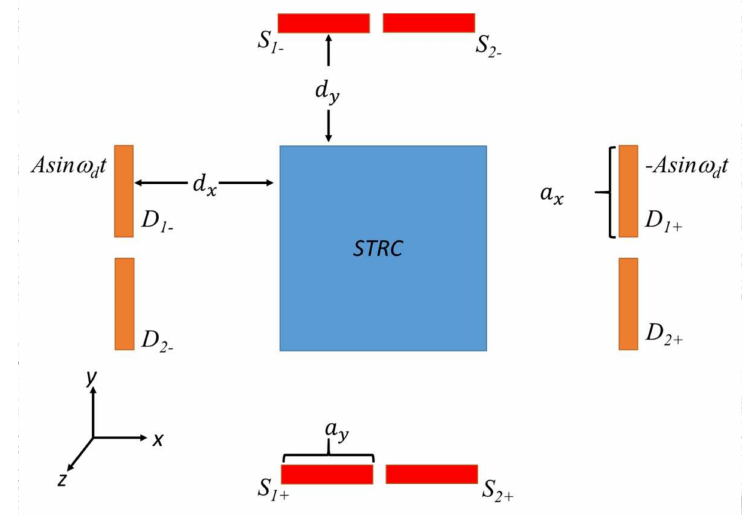
Figure 1. The capacitance interface of the modeled